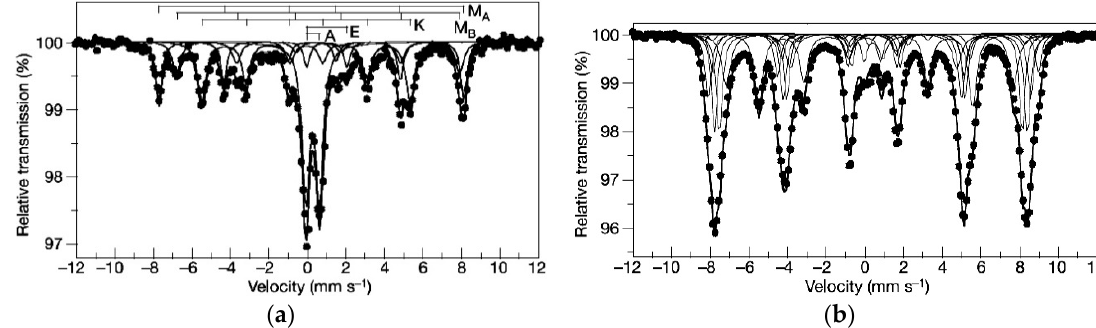
Figure 37. Mössbauer spectra of graphite nodule extracted from Canyon Diablo IAB-MG iron meteorite measured at room temperature ( a ) and at 15 K ( b ). Indicated spectral components are the results of the fits. Adapted from [86].